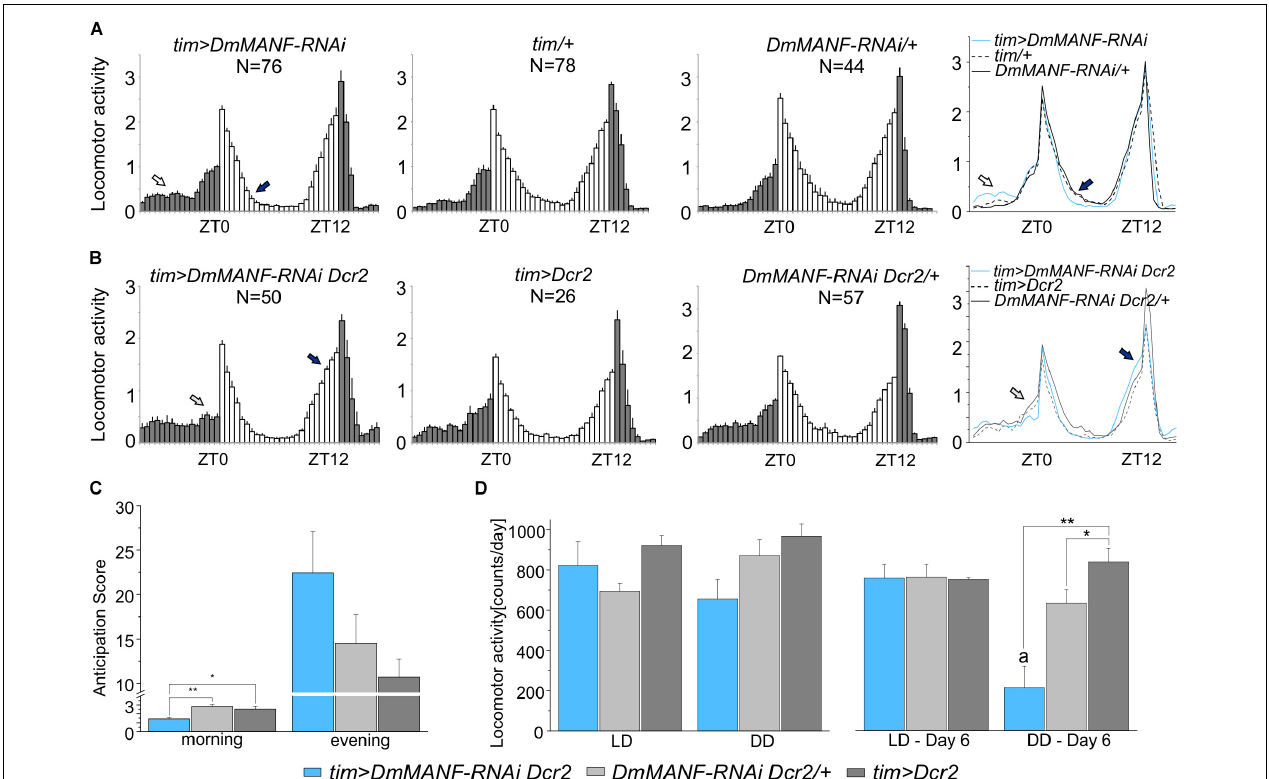
FIGURE 3 | Locomotor activity in LD 12:12 and DD of flies with DmMANF silencing in tim -expressing cells. (A) Mean activity profiles (averaged counts per minute) in LD12:12 of tim > DmMANF-RNAi in comparison to control lines. The open arrow shows increased night-time activity while the solid arrow indicates a faster decrease in the morning peak. (B) Mean activity profiles (averaged counts per minute) in LD12:12 of tim-GAL4 driven UAS-DmMANF-RNAi UAS-Dicer2 flies in comparison to control lines. The open and solid arrows indicate lack of morning anticipation and robust evening anticipation, respectively. N = number of individuals; grey and white bars indicate the dark and the light phases of LD, respectively; mean ± SEM. (C) Morning and evening anticipation score in tim > DmMANF-RNAi Dcr2 flies and controls in LD 12:12. Morning anticipation score (1.41 ± 0.2) of DmMANF-deficient flies was significantly lower when compared to tim > Dcr2 (2.83 ± 0.2; p = 0.01) and +/Dm MANF-RNAi Dcr2 (2.52 ± 0.3; p = 0.032) controls. One-way ANOVA followed by Bonferroni post hoc test: * p < 0.05, ** p ≤ 0.01; means ± SEM. (D) Mean locomotor activity (count/day) of tim-GAL4 driven UAS-MANF-RNAi UAS-Dicer2 flies for mean values of overall 6 days of the experiment in LD 12:12 and DD (graphs on the left) and calculated only for the sixth day in LD 12:12 or DD (graphs on the right). The activity of those flies on the sixth day of DD was significantly lower (216 ± 93) when compared to tim > Dcr2 (640 ± 67, p = 0.023) and +/ DmMANF-RNAi Dcr2 (847 ± 68, p = 0.003) controls - one-way ANOVA followed by Bonferonni’s post hoc test. Moreover, the activity of tim > DmMANF-RNAi Dcr2 flies on the sixth day in DD was also significantly lower than on the sixth day in LD 12:12 (766 ± 57, p = 0.004) - t -student Test. * p < 0.05, ** p ≤ 0.01, a – p < 0.05 between activity in the sixth day of DD and the sixth day of LD12:12; means ±